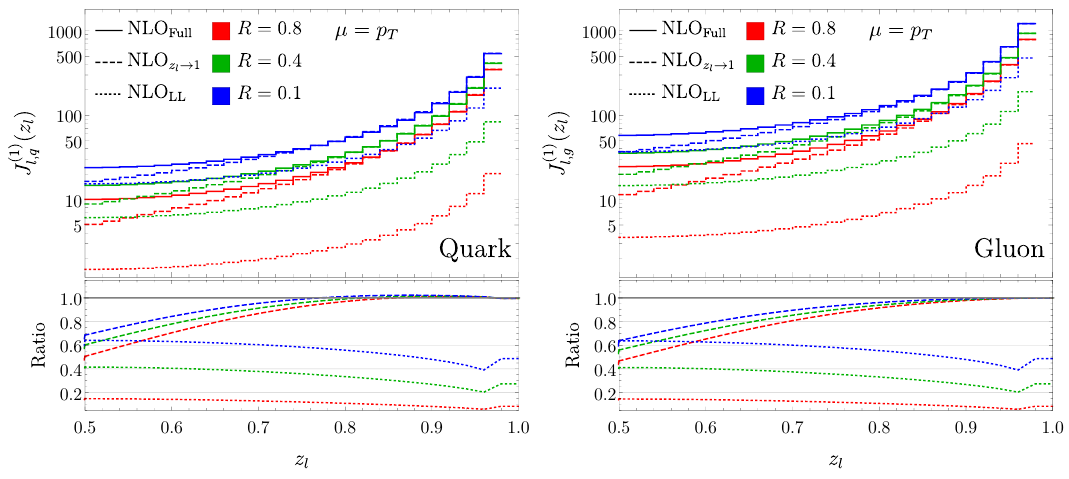
Figure 1 . The full (solid) leading-jet function at O ( (cid:11) s ), its (cid:11) s ln R contribution (dotted), and the z l ! 1 approximation (dashed), for R = 0 : 8 ; 0 : 4 ; 0 : 1 (red, green, blue). Note that the last bin which is negative (and ensures the sum rule in eq. (2.9)) does not appear on the log plot. In the panel below each (cid:12)gure the ratio with the full NLO result is